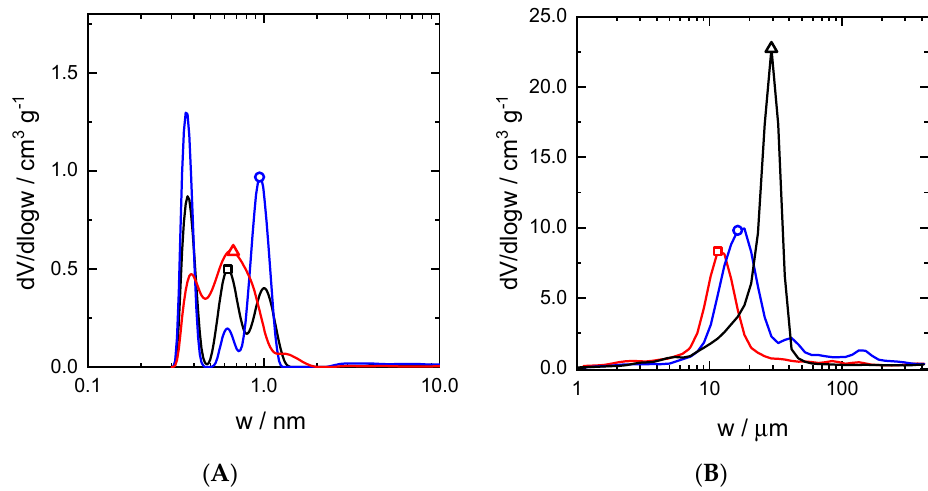
Figure 3. Pore size distributions, obtained: ( A ) By applying NLDFT to nitrogen isotherms, and ( B ) by mercury intrusion porosimetry, for samples SucNaCl0.80 ( □ ), SucNaCl1.00 ( ○ ) and SucNaCl1.25 ( △ ).